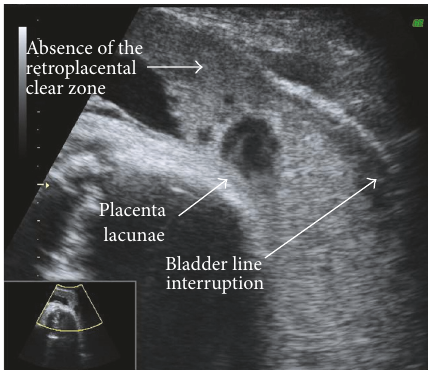
Figure 1: Representative 2D gray scale ultrasound scan for morbidly adherent placenta. Ultrasound scan shows bladder line interruption, absence of the retroplacental clear zone, and placenta lacunae in morbid adherent